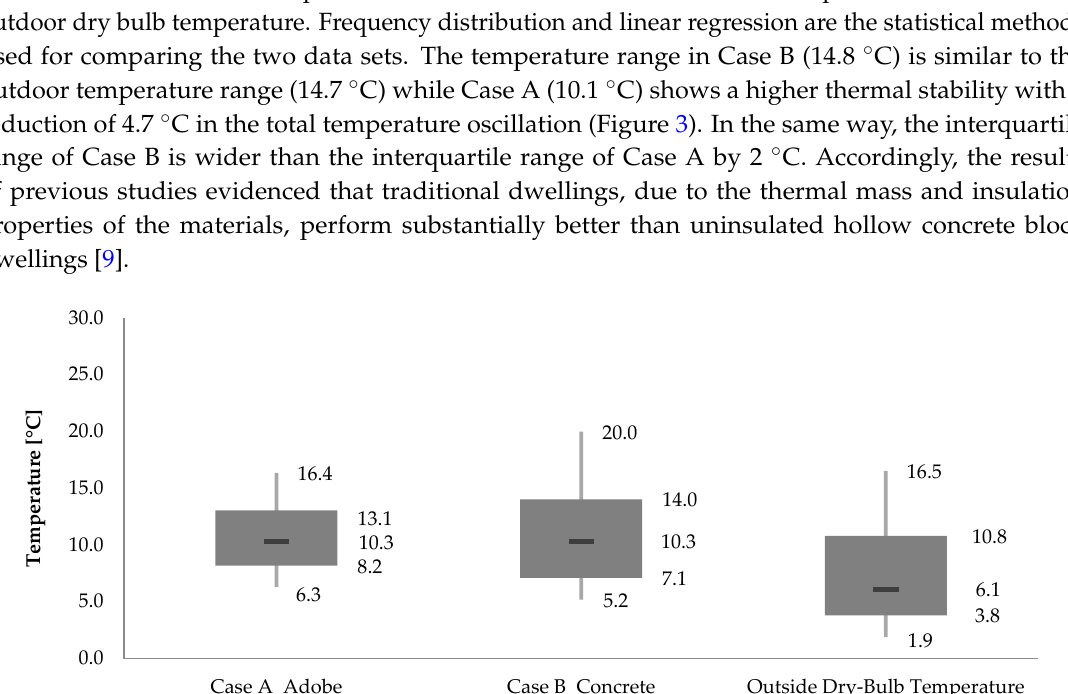
Figure 4. Observed temperatures from Case A, Case B, and exterior.